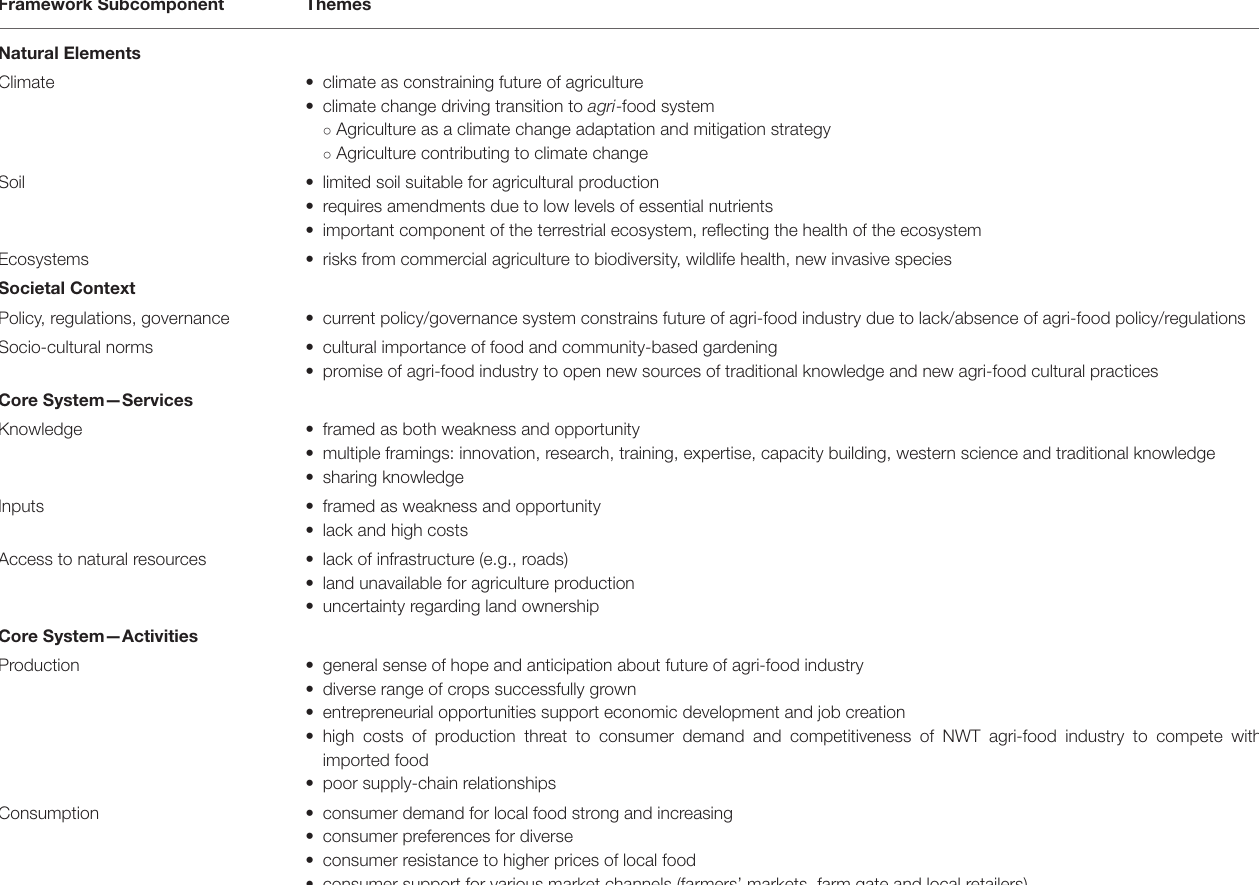
TABLE 2 | Key themes framing the dominant subcomponents of the adapted foods systems